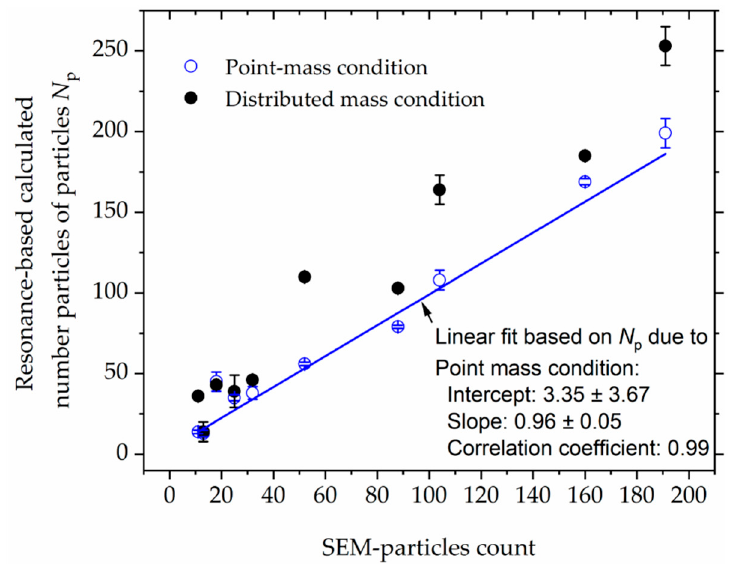
Figure 14. Comparison of the number of magnetic polystyrene microparticles on both TCant1 and TCant2 cantilever sensors. The number of particles N p was determined from the measured resonant frequency responses (considering both point-mass and distributed mass conditions) and is compared with the SEM-particle counting. The blue line depicts an error-weighted linear fit for N p at point-mass condition.